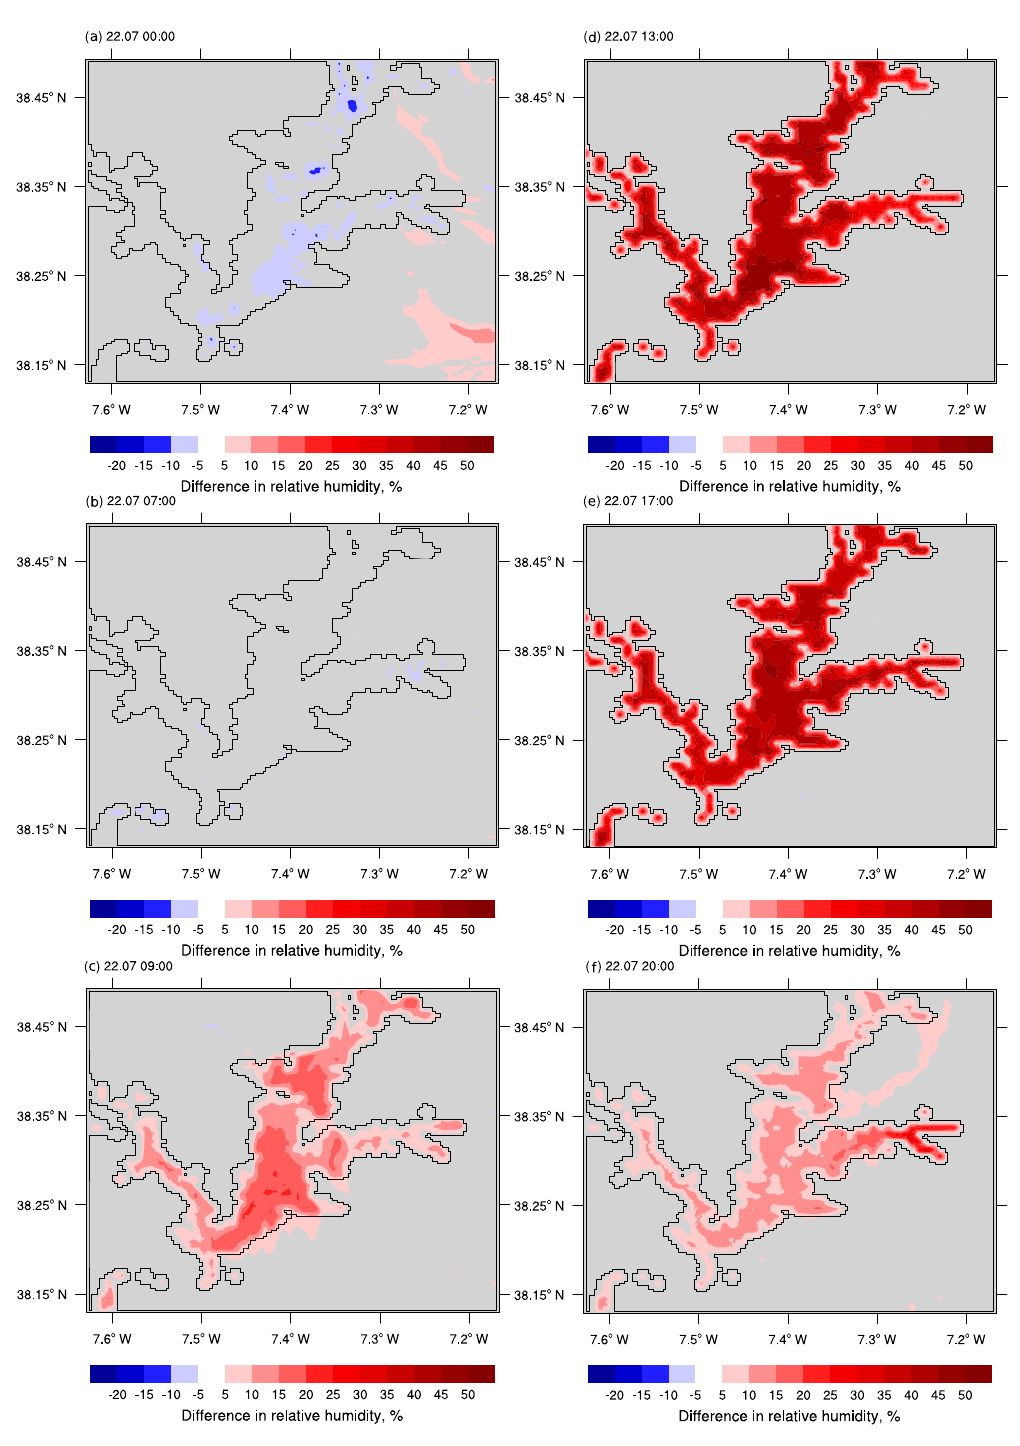
Figure 11. 2m relative humidity anomalies (in filled contours) on 22 July 2014 in domain C.